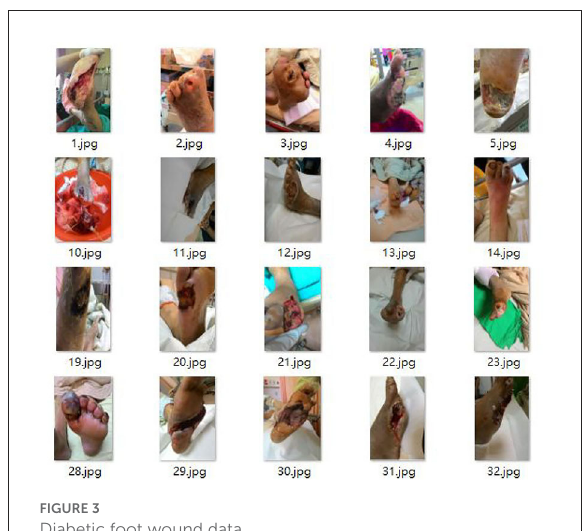
FIGURE3 Diabetic foot wound data.